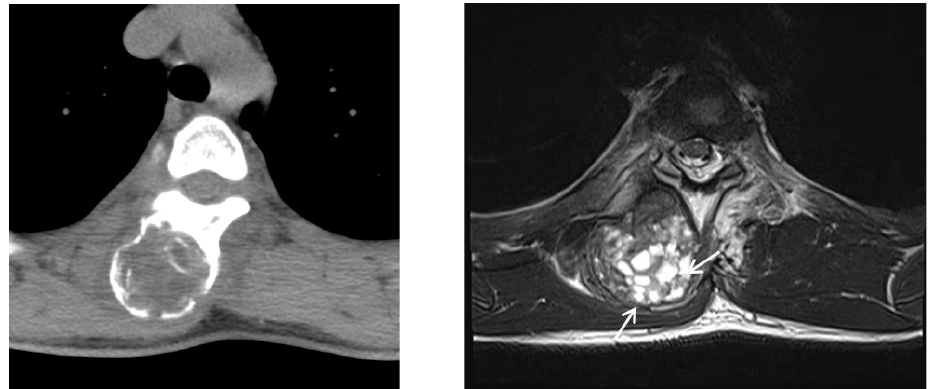
Figure 6. (Left) On follow-up CT, the paraspinal mass had enlarged compared with previous CT images. Extrinsic erosion to adjacent bone was also noted. (Right) Follow-up MR imaging demonstrates that multiple small cystic lesions with fluid–fluid levels (arrows) had developed in the mass, which suggested aneurysmal bone cystic change.